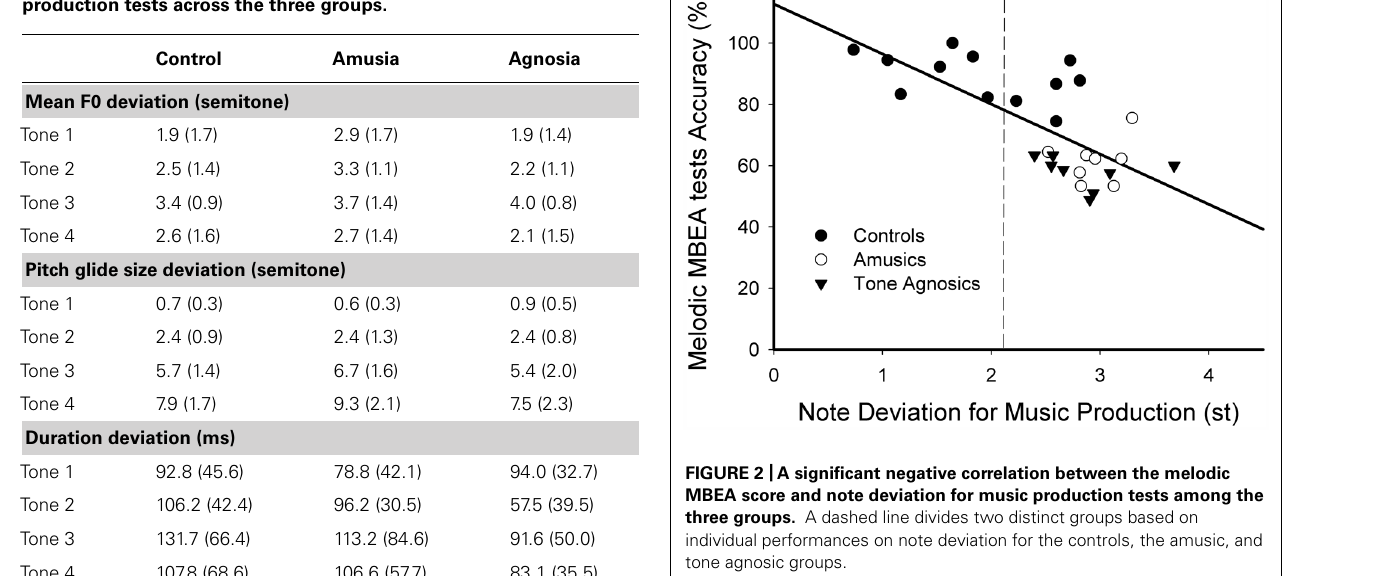
Table 4 |The results of the objective analysis for the two lexical tone production tests across the three groups.